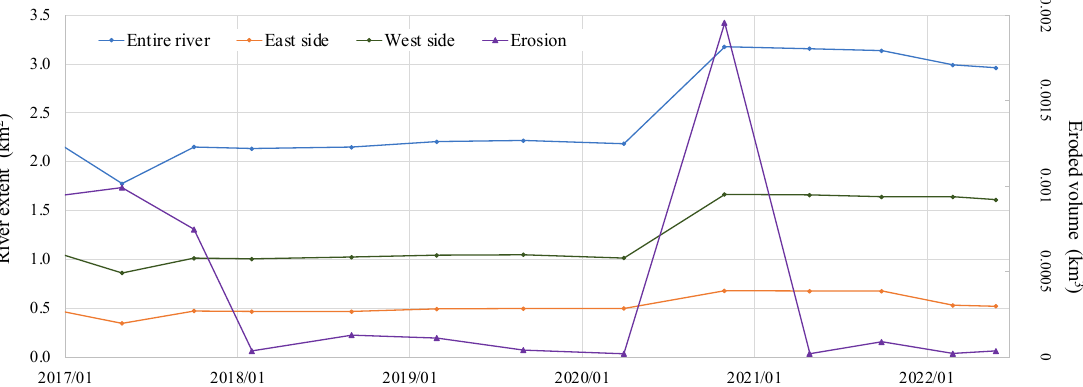
Figure 9. Time series of the extents of the entire Bone River, east and west side, and eroded volumes from 2017 to